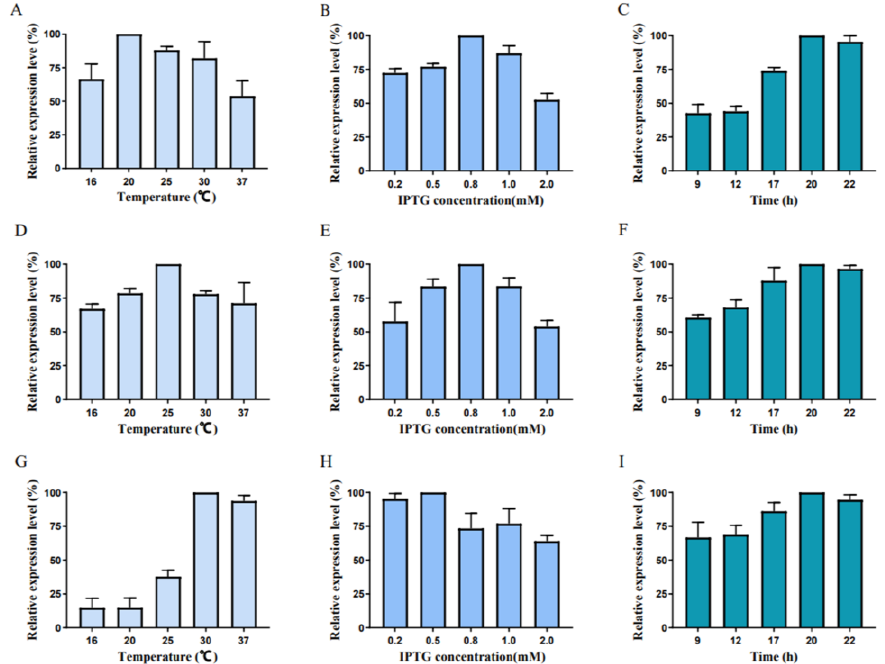
Figure 6. Fermentation level optimization of recombinant proteins. ( A ) Different induction temper- atures of FumTSTA; ( B ) Different IPTG concentration of FumTSTA; ( C ) Different incubation time of FumTSTA; ( D ) Different induction temperatures of FumPHTA; ( E ) Different IPTG concentration of FumPHTA; ( F ) Different incubation time of FumPHTA; ( G ) Different induction temperatures of FumUPTA; ( H ) Different IPTG concentration of FumUPTA; ( I ) Different incubation time of FumUPTA.